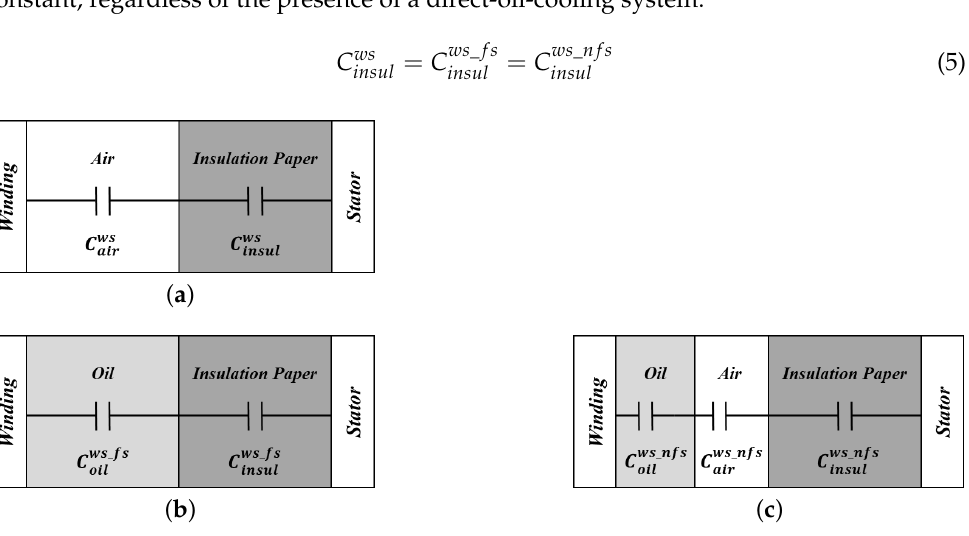
Figure 4. Winding-to-stator capacitance circuits. ( a ) Slot without cooling oil. ( b ) Oil-filled slot. ( c ) Oil-unfilled